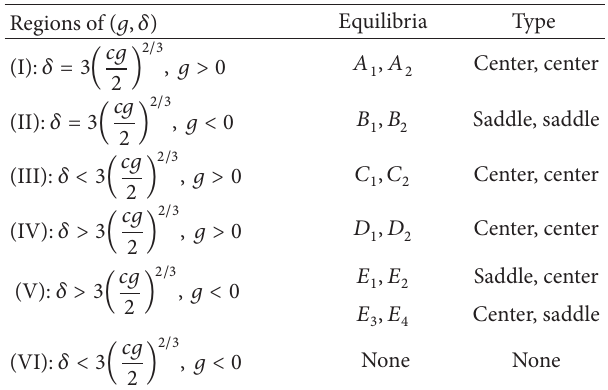
Figure 1: An example of the number of roots for 𝑓(𝑅) depending on the sign of 3(𝑐𝑔/2) 2/3 − 𝛿 with 𝑐 = 1 , 𝑔 = −1 . There are 4 roots for 𝛿 > 1.8899 , 2 roots for the threshold 𝛿 = 1.8899 , and no root for 𝛿 < 1.8899 . Table 1: Type of equilibria of